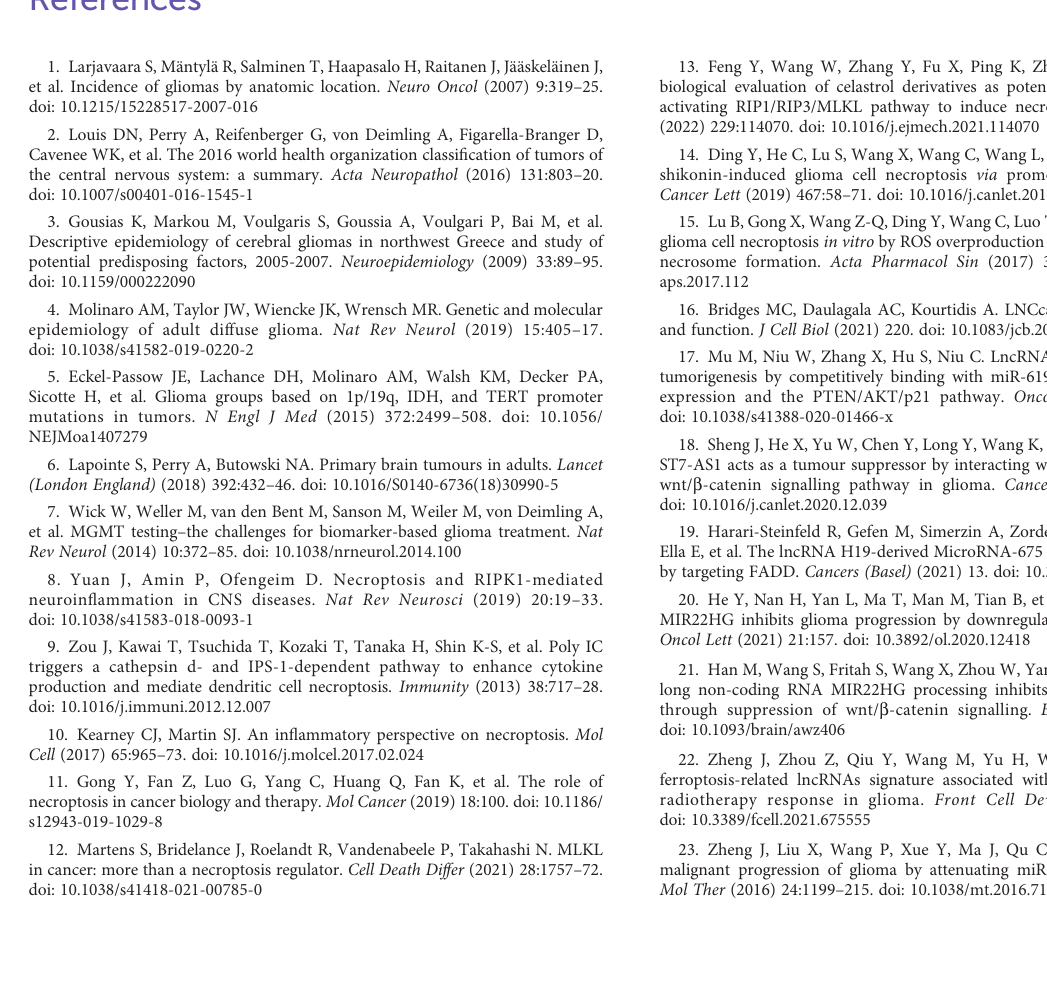
SUPPLEMENTARY FIGURE 1 Differential expression of GABA receptors in high and low RS cohort. SUPPLEMENTARY FIGURE 2 Kaplan – Meier survival analysis of the different grades high ‐ risk and low ‐ risk groups based on the 9 necroptosis-related LncRNAs. SUPPLEMENTARY TABLE 2 The necroptosis process related lncRNA signatures. SUPPLEMENTARY TABLE 3 Predicted binding miRNAs of selected